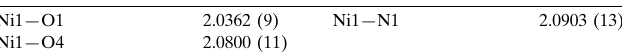
Selected bond lengths (A˚ ).